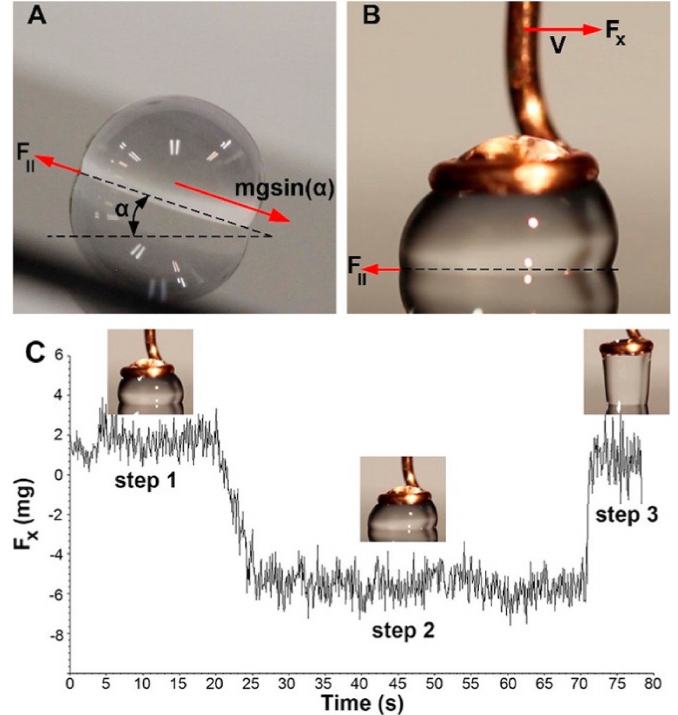
Figure 27. Side-view optical image of 20 µ L water drop: ( A ) sliding on a hydrophobic surface at a tilt angle α . When the drop begins to slide, the sliding angle is equal to α ; ( B ) sheared on a hydrophobic surface at a velocity V and corresponding applied force F x . F (cid:107) is the friction force at the interface between the water drop and the surface; and ( C ) plot of friction data between a 20 µ L water drop and an OTS-modified hydrophobic silicon surface collected using a nanotribometer at various stages in the measurement; step 1—Approach, step 2—Shear, step 3—Retract and move to start position. Corresponding optical images of the water drops in contact with the surface during the various steps are also shown as insets [174].